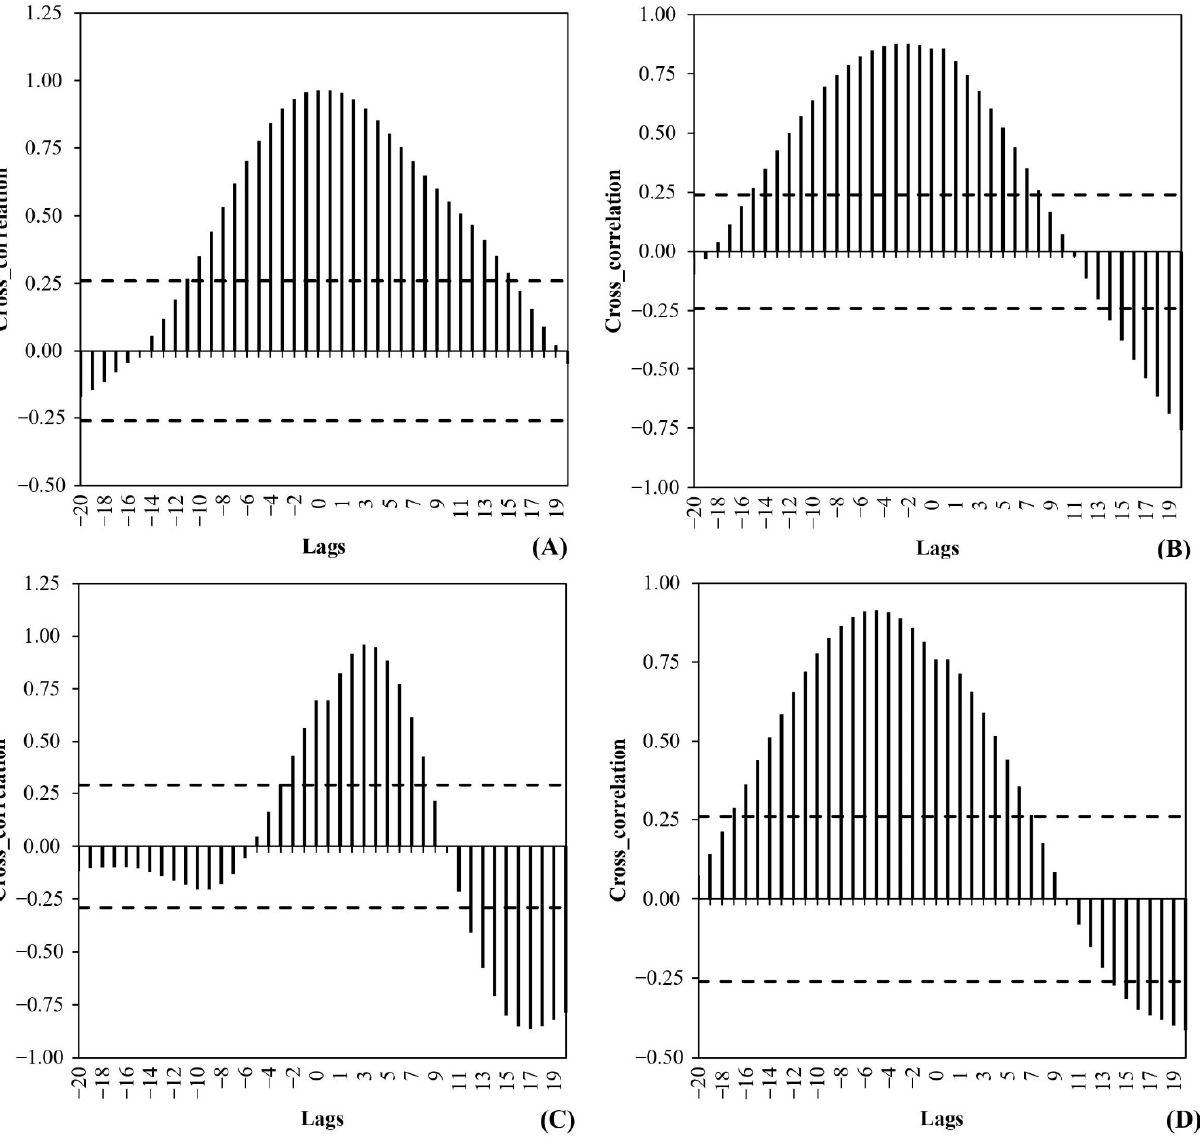
Figure 3. Cross ‐ correlation (CC) plots between SARS ‐ CoV ‐ 2 signals and active cases in WWTPs ( A – D ). The negative and positive lags correspond to the forward and backward lags between the incidence time series and viral load time series. The solid dashed lines indicate the significant levels at 95% confidence.